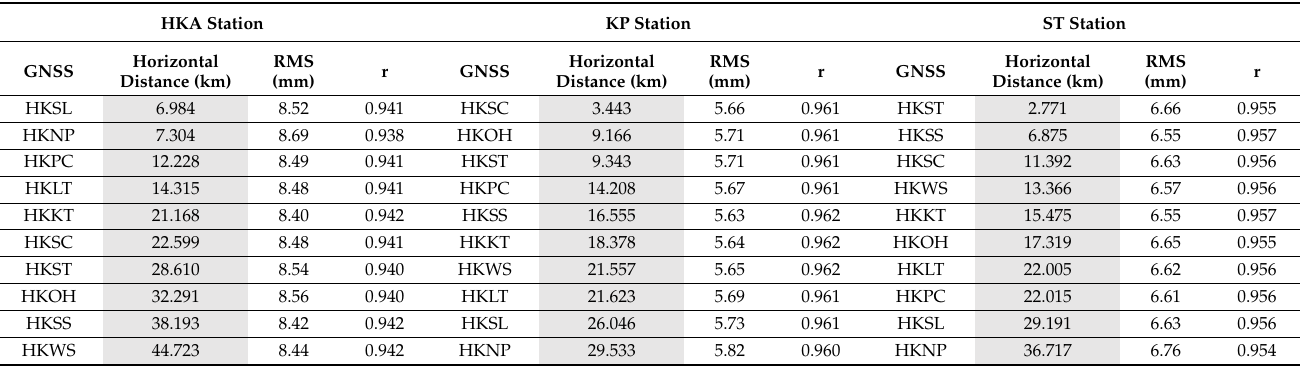
Table 5. Calibration performances of TH-PETs resulting from the temperature, pressure, mean Julian Date (MJD), and ten sets of zenith total delay (ZTD) time series at the three weather stations (HKA, KP, and ST) over the period 2008–2019. The horizontal distances between each pair of GNSS/weather stations are illustrated.